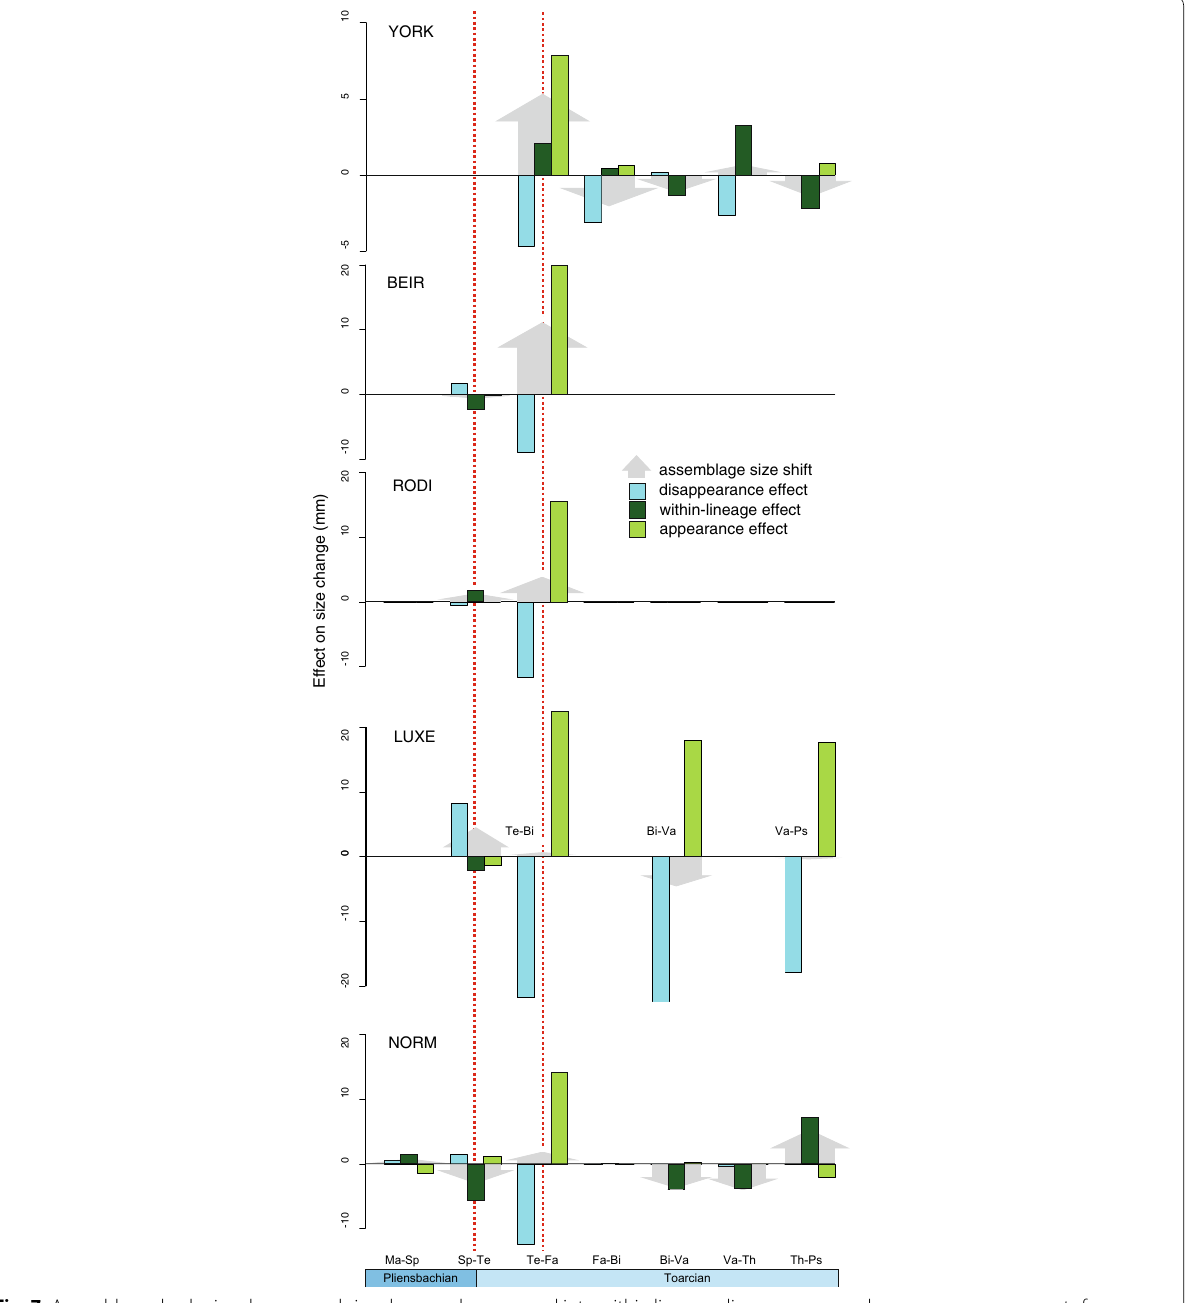
Fig. 7 Assemblages body size changes and size changes decomposed into within lineage, disappearance and appearance components for the Cleveland (YORK), Lusitanian (BEIR), Asturian (RODI), Eastern Paris (LUXE) and Western Paris (NORM) basins. These are based on all measured specimens rather than species means. Dotted vertical red lines indicate the two pulses of the second ‐ order Toarcian